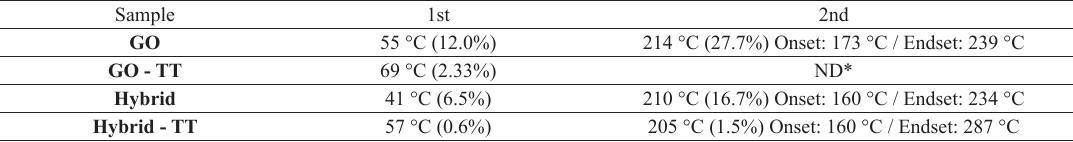
Table 2. Main thermal events with the maximum decomposition temperature (ºC) and mass loss (%) values detected at the DTG curve for the samples. Sample